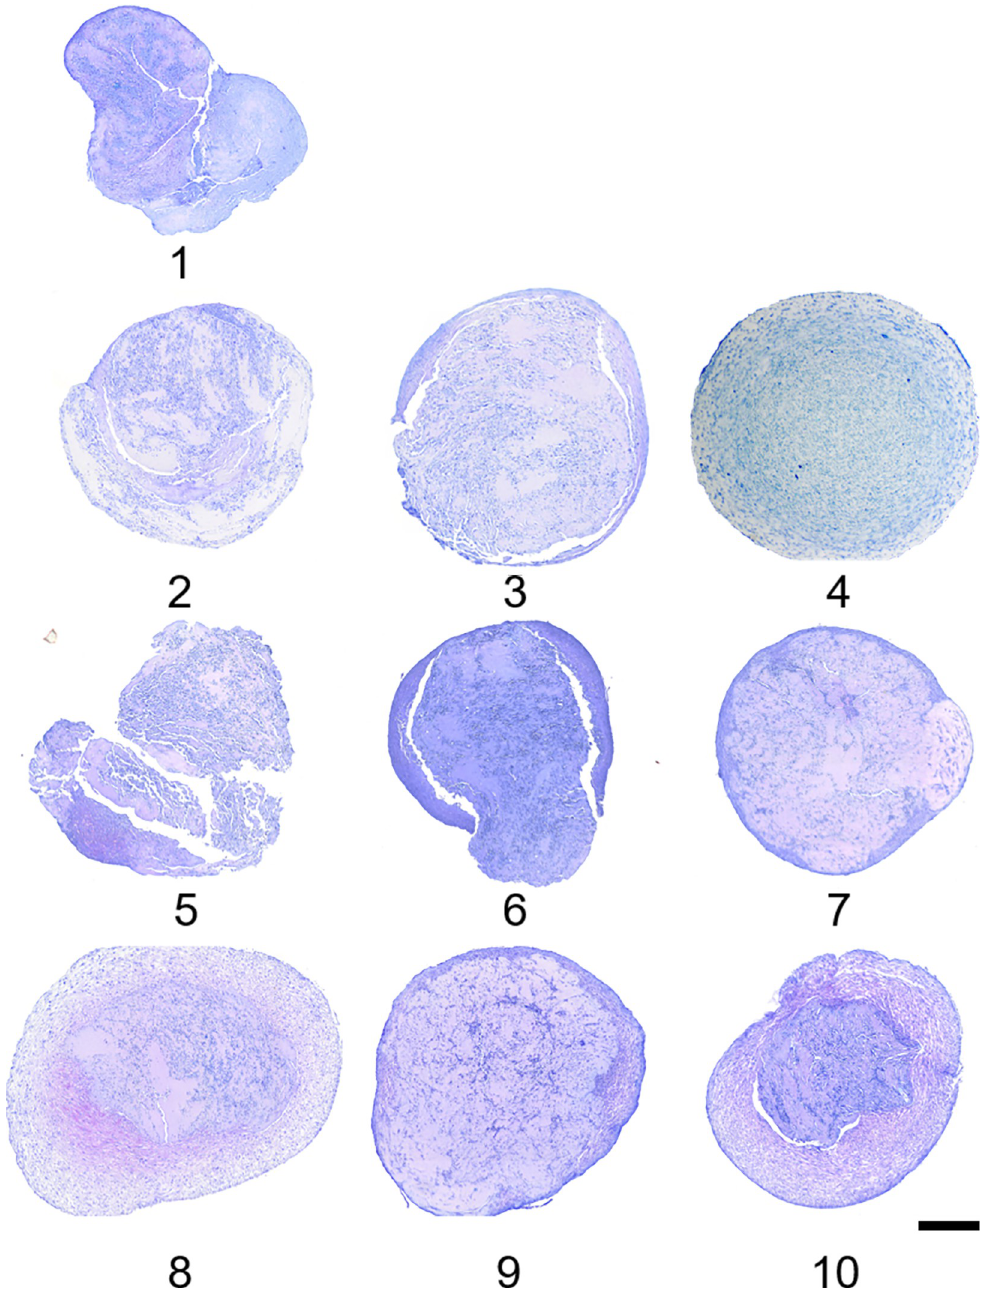
Fig 5. Toluidine blue histology of cMSC constructs for initial chondrogenic screening. Constructs from Fig 4 were fixed in 10% NBF, processed, embedded, cut at 4 μ m sections, and stained in 1% toluidine blue. Representative images are provided for each of the 10 treatment groups. Groups containing the low concentrations of bFGF and/or BMP-2 exhibited irregular margins, large intra-construct defects, limited proteoglycan staining, and inconsistent distribution of cMSCs (groups 1,2,3,4,6). Treatment groups containing the high concentrations of bFGF or BMP-2 were larger, with smooth margins, enhanced proteoglycan deposition, and more uniformly distributed cMSCs (purple coloration, groups 4,8,10). Bar = 500 μ